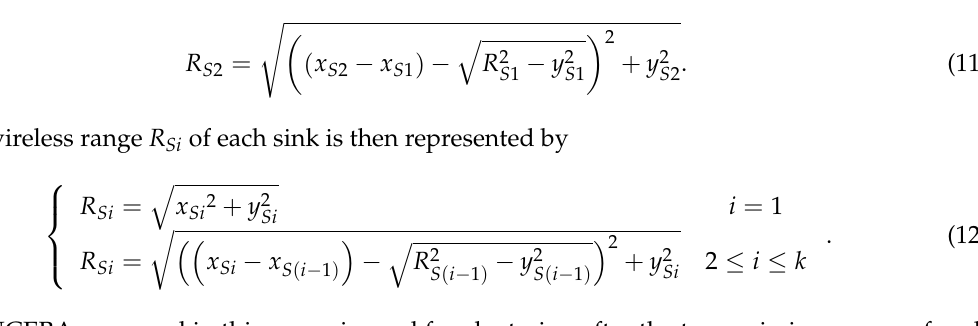
Figure 5. Selection of wireless ranges by three sinks in the network: ( a ) extremely large; ( b ) suitable; and ( c ) extremely small.